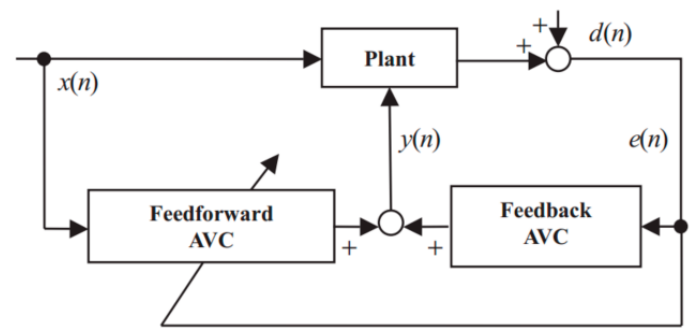
Figure 23. Schematic of the hybrid controller [70].